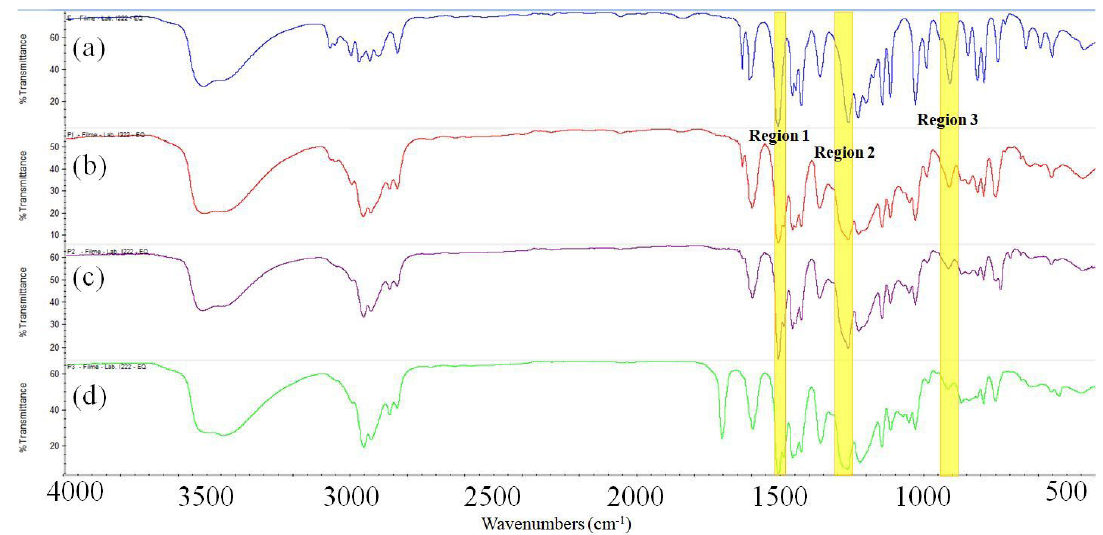
Figure 2. FTIR spectra: (a) eugenol, (b) P10, (c) P20, and (d)